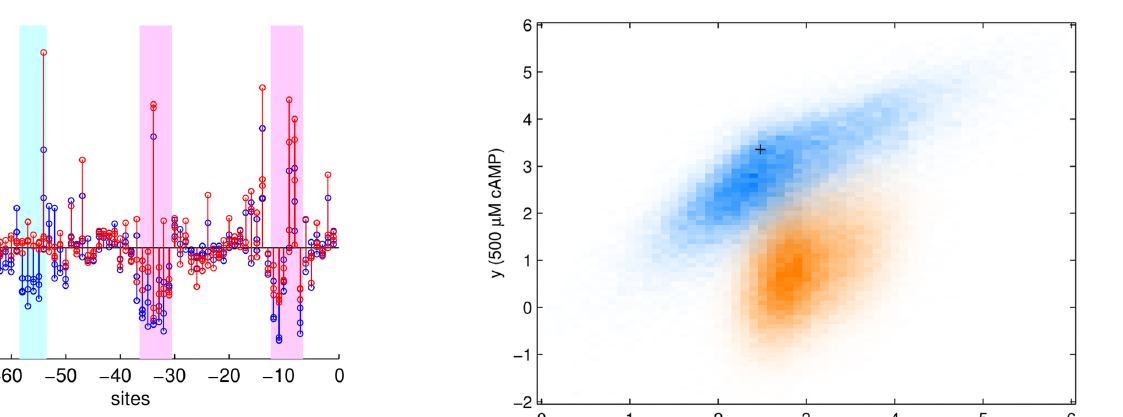
Figure 4. (blue) coefficients b i for the non-epistatic model with no-glucose (normal levels of cAMP) (red) with glucose (no cAMP). CRP is activated by cAMP and does not bind without it.